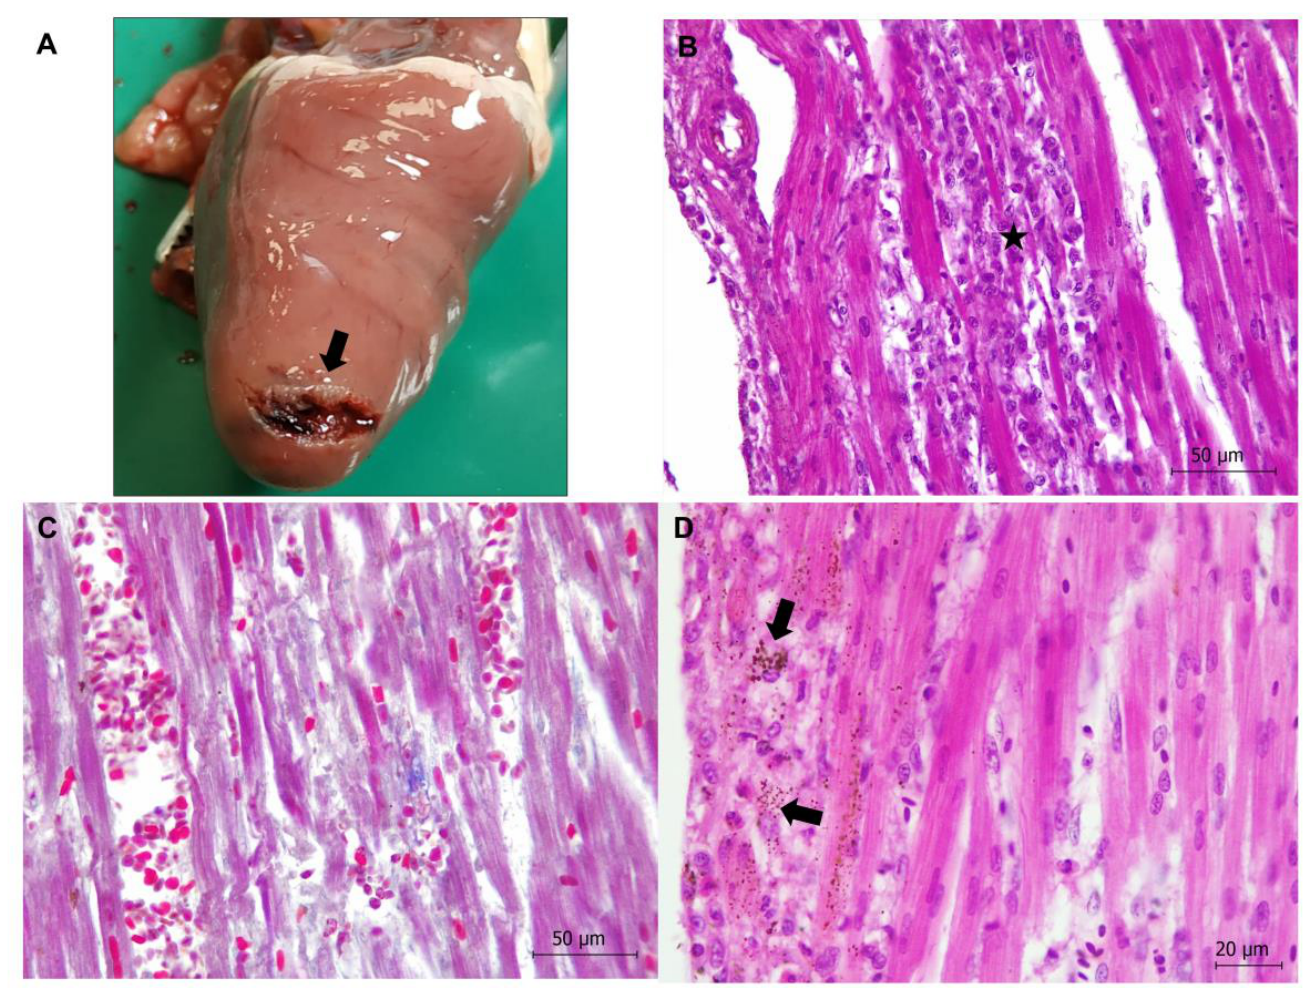
Figure 5. Rupture of the heart apex and cardiomyopathy in a Cantabrian capercaillie. ( A ) Rupture of the heart apex with associated hemorrhage is observed (arrow). ( B ) Fragmentation of myocardial fibers, as well as prominent inflammatory infiltrate mainly made up of macrophages (star), can be observed. Hematoxylin-eosin stain. ( C ) Myodegeneration is highlighted using Mallory Azan staining. Only the unaffected fibers are stained in red. ( D ) Calcification (mineralization) (in black, arrows), hyalinization, necrosis of muscle fibers, and an infiltrate of macrophages are observed. Von Kossa stain.